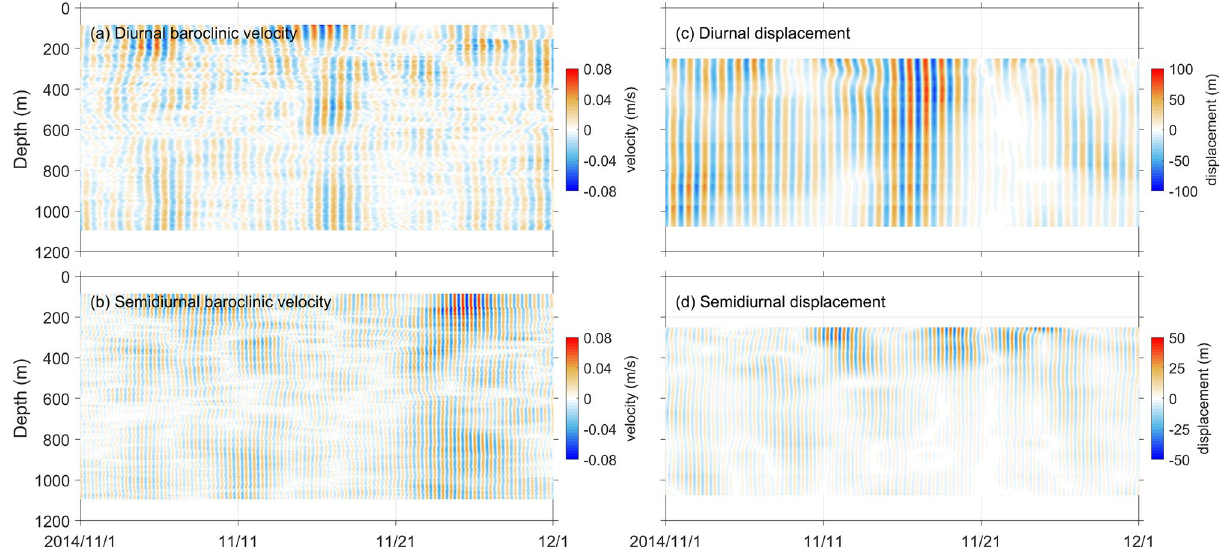
Figure 3. Diurnal and semidiurnal ( a and b ) baroclinic currents (shading, unit: m/s) and ( c and d ) isothermal displacements from 1 November to 31 December 2014 at